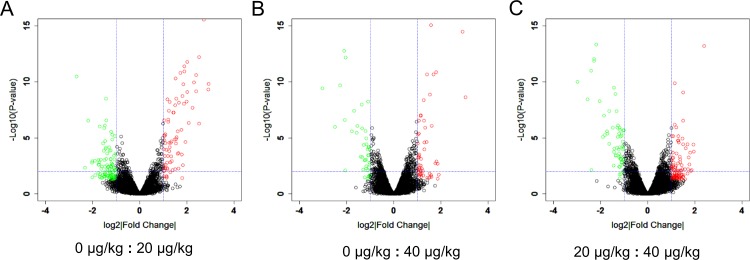
Scatterplot of DEHP treated ovarian gene expression profiling.Red plot represents genes up-regulated significantly and green plot represents genes down regulated significantly. (A) Control group vs. 20 μg/kg DEHP-treatment group, (B) Control group vs. 40 μg/kg DEHP-treatment group, (C) 20 μg/kg DEHP-treatment group vs. 40 μg/kg DEHP-treatment group.